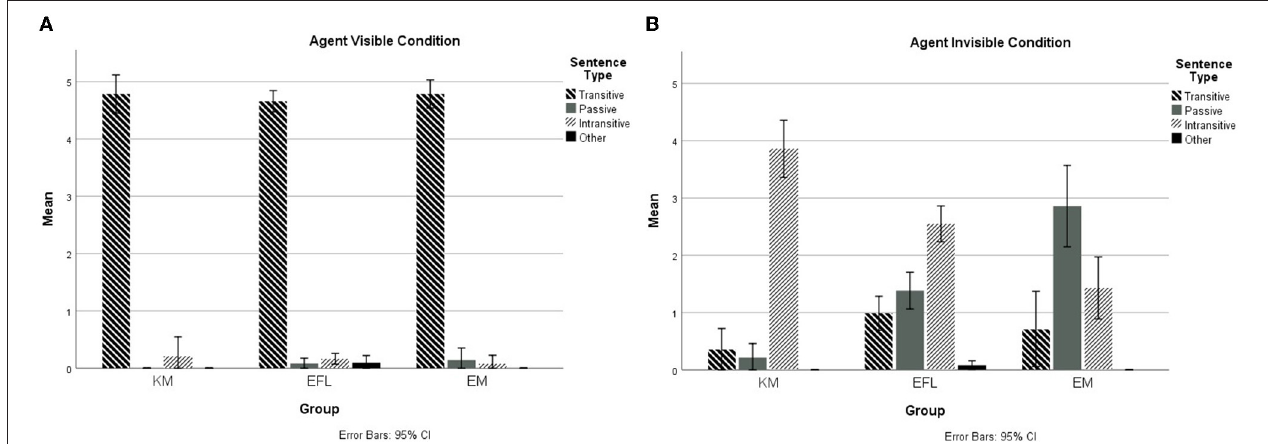
FIGURE 2 | Frequency of different sentence types in Agent Visible (A) and Agent Invisible (B)